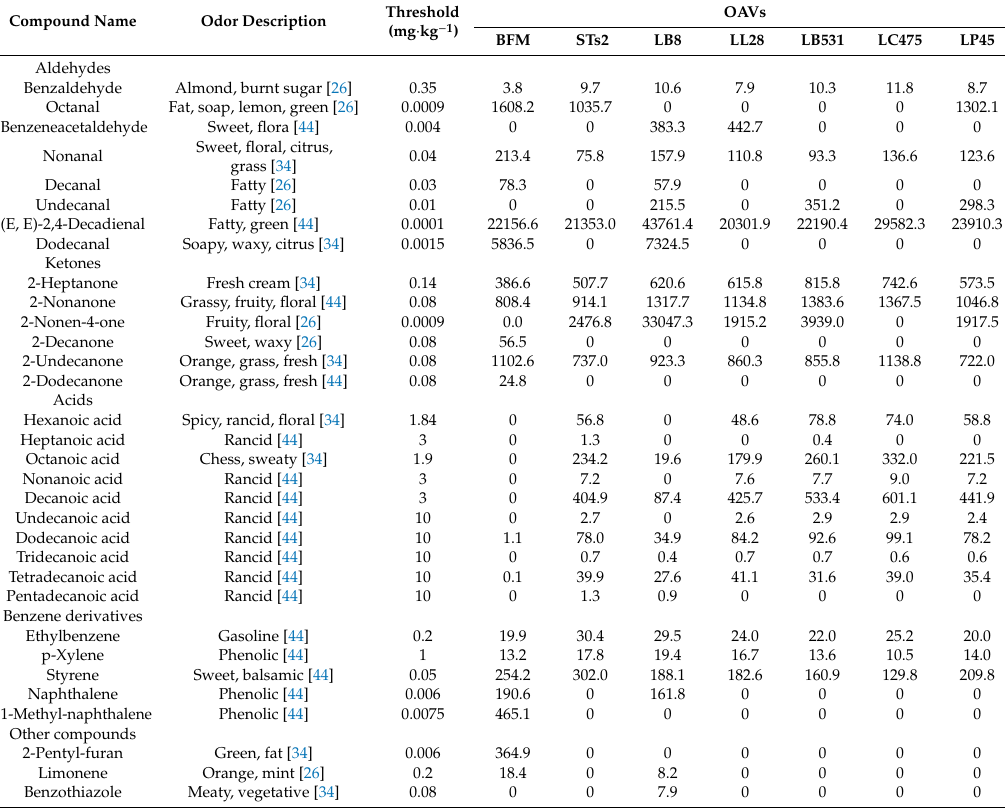
Table 2. Odor activity values (OAVs) of volatile compounds in the milks fermented with di ff erent starter